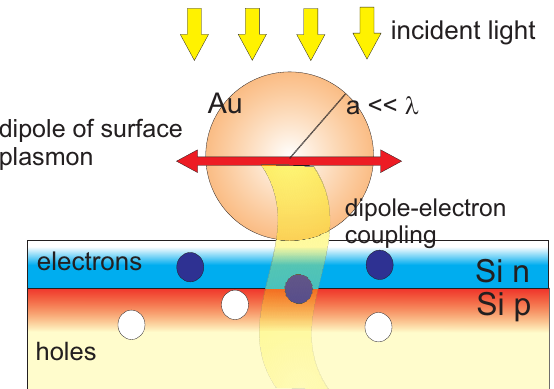
Figure 2. The spherical metallic nanoparticle (Au, Ag or Cu) with radius a is deposited on the semiconductor substrate (for example Si) with an active n-p junction embedded close (in depth < 1 µ m) to the upper surface with the nanoparticle deposited. High plasmon-absorption rate of the nanoparticle with size a ∈ ( 10,70 ) nm (Au) [24] guaranties the high level excitation of the dipole plasmon mode by the incident light. The very effective channel for the energy transfer from the dipole-surface-plasmon to the band electrons is opened via near-field (and thus sub-photon, i.e., on the distance much lower than λ –the plasmon resonance wave length) coupling of dipole plasmon oscillations with band electrons in the semiconductor substrate, especially in the n-p junction, which results in a photo-current in a photo-diode